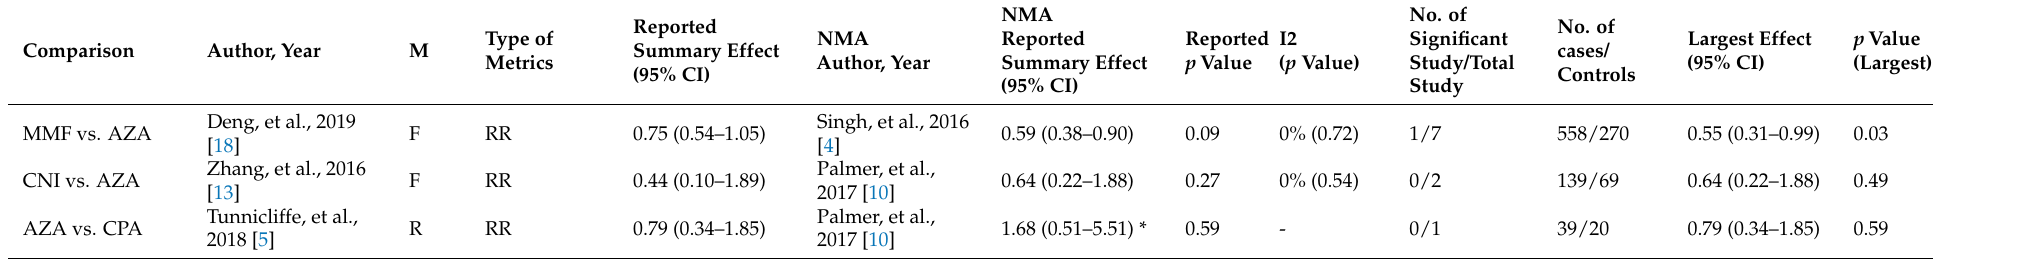
Table 14. Relapse during maintenance therapy (compared with Network meta-analysis).